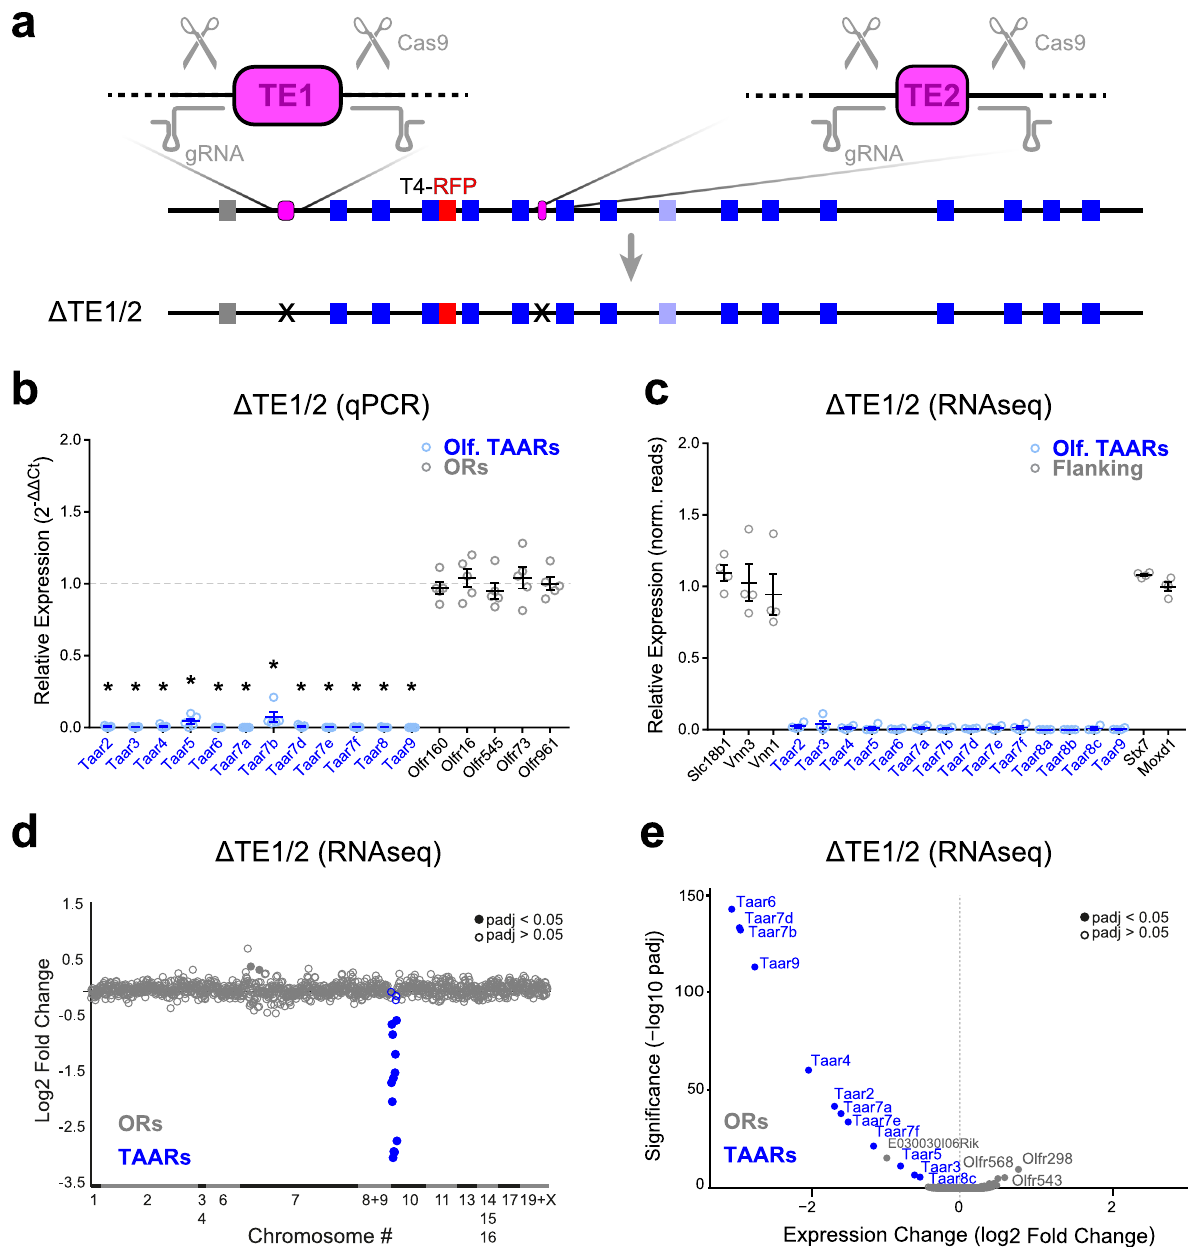
Fig. 6 TE1 and TE2 are required for TAAR gene expression. CRISPR-based gene editing was used to generate a double, cis deletion of both TE1 and TE2. a Diagram showing locations of gRNAs (gray) designed to target PAM sites fl anking TE1 and TE2 (magenta). The double deletion ( Δ TE1/2) was generated on a chromosome harboring a previously targeted Taar4-RFP allele (red). Bottom, diagram of Δ TE1/2 in cis with Taar4-RFP. Deletion is marked (X). b Relative fold expression of TAAR (blue) and control OR (gray) genes measured using qPCR (2 - ΔΔ Ct method) from olfactory mucosa. Error bars indicate mean ± SEM. Taar8 primers amplify all 3 family members. n = 5 mice per genotype. * p < 0.0001; two-sided, one-way ANOVA, Dunn – Š idák correction for multiple comparisons. c Relative expression ( Δ /wt avg normalized counts from DESeq2) for olfactory TAAR genes (blue) and genes fl anking the TAAR cluster (gray). Error bars indicate mean ± SEM. n = 4 mice per genotype. d Change in expression (log 2 fold change) of all ORs (gray) and TAARs (blue) measured via RNAseq ( n = 4 mice for each genotype). e Volcano plot ( − log 10 adjusted p value vs. log 2 fold change) from DESeq2 analysis of RNAseq data from homozygous Δ TE1/2 and wild-type littermate control olfactory mucosa showing that TAAR genes are selectively affected by deletion. All genes with normalized counts >10 are plotted. Filled circles indicate genes with adjusted p values <0.05 two-sided (DESeq2) Wald test corrected for multiple comparisons (Benjamini and Hochberg). p -values for RNAseq data can be found in Source Data